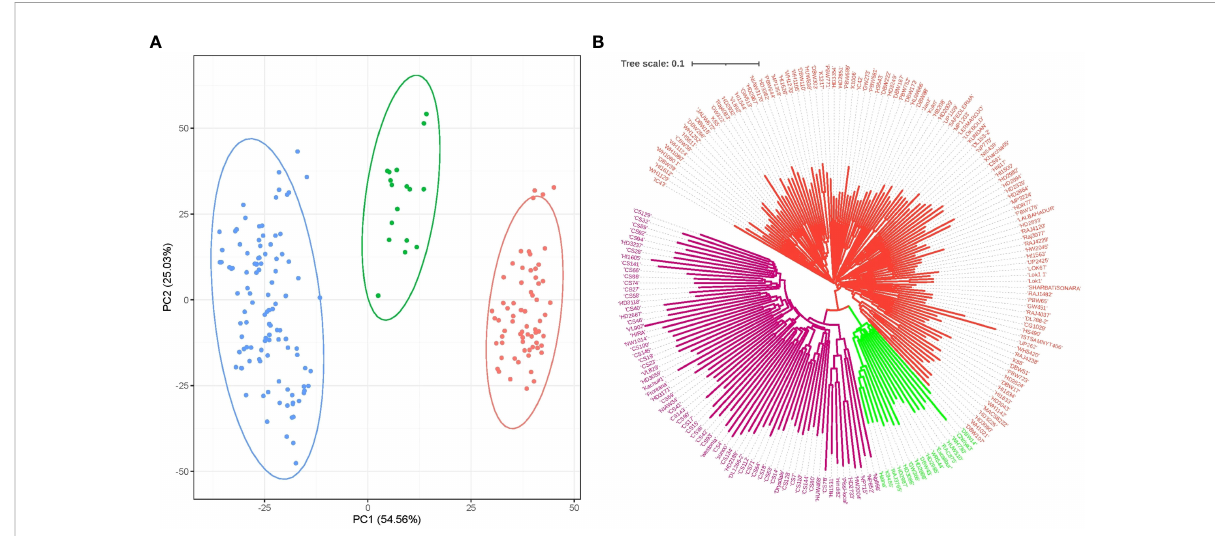
FIGURE 5 Population groupings in the GWAS panel from different models. (A) Principal component-based grouping based on PC1 vs. PC2; and (B) neighbor-joining tree based on a distance